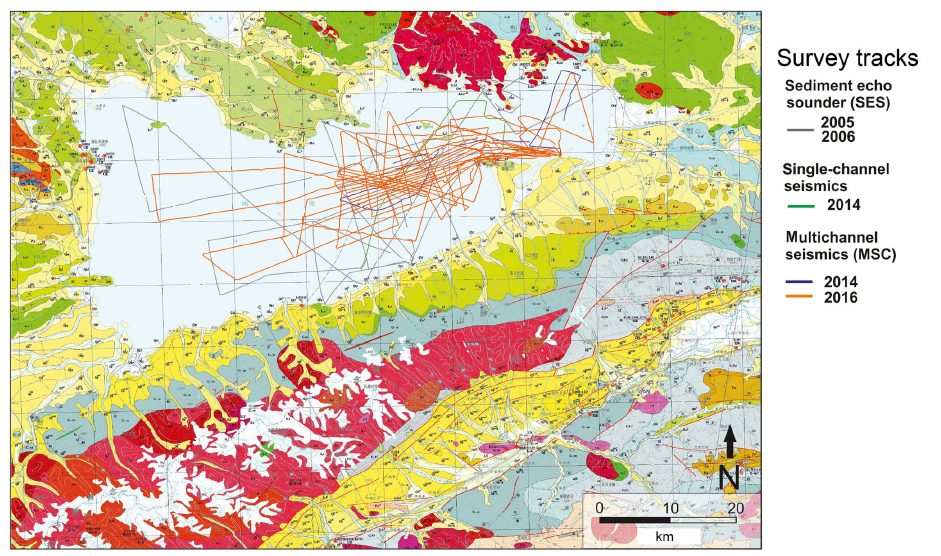
Figure 3. Geological map of the Nam Co area (green: Cretaceous; blue: Jurassic; gray: Permian and Carboniferous; red: magmatic and metamorphic; yellow: Quaternary; white: modern glaciers of the Nyainqêntanglha mountain range) (Wu et al., 2011, modified) and cruise tracks of 2005/2006 echosounder (gray), 2014 single channel (green), and 2014/2016 multichannel seismic surveys (purple and